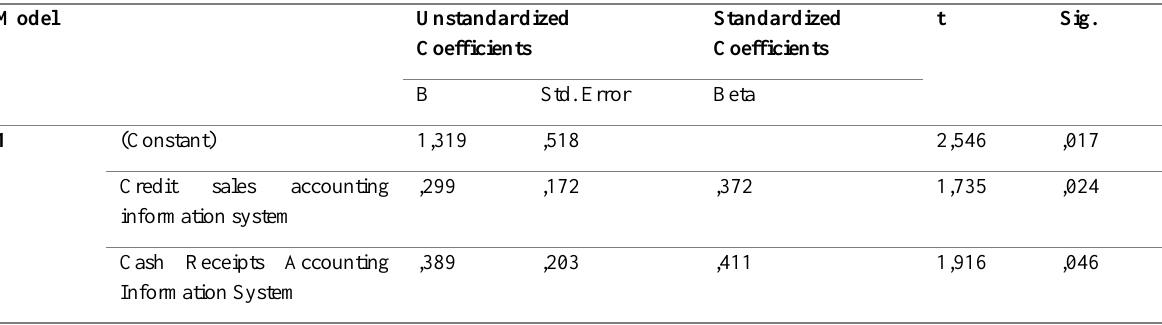
Table 4: Hypothesis Test Results (t